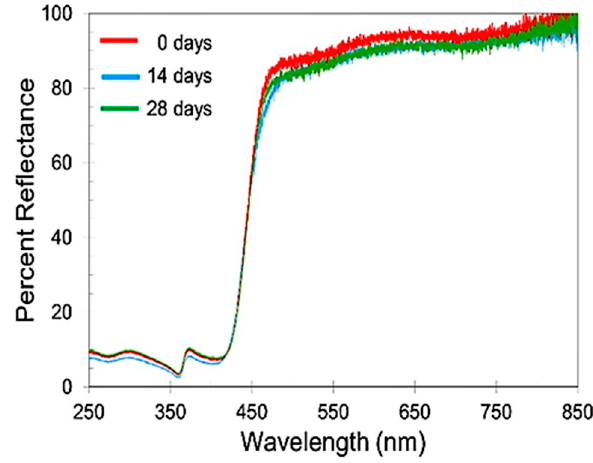
Figure 7. UV-Vis diffuse reflectance spectra showing the light stability of CsAgBiCl 6 after two and four weeks of light exposure. Reproduced with permission from Reference [36]. American Chemical Society, 2016.